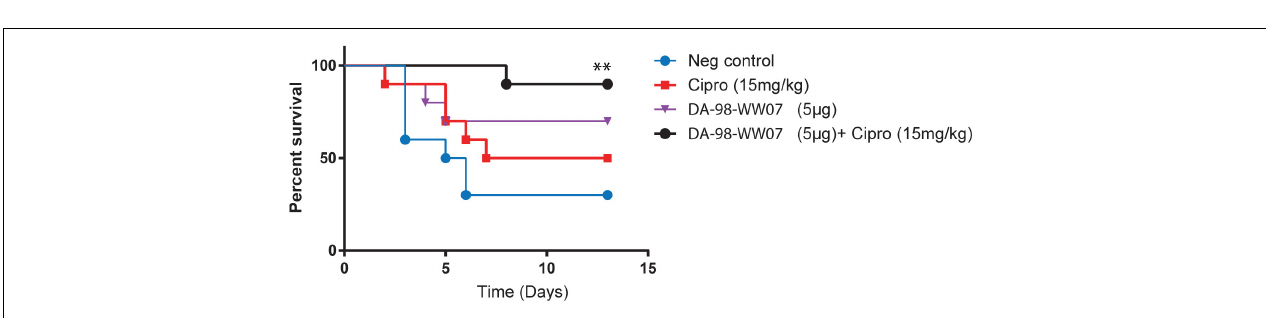
FIGURE 4 | DA-98-WW07 protected mice from B. anthracis infection. Mice survival following infection with B. anthracis . Kaplan-Meier curves of C57BL/6 mice infected with B. anthracis . (A) Mice are treated with indicated TLR agonists 2 h prior to infection and 24 or 48 h post infection. (B) Surviving mice were re-challenged with B. anthracis 20 day post initial infection. The number of mice that were re-challenged in the different groups are DA-98-WW07 –10 µ g (4 mice), DA-98-WW07 –30 µ g (5 mice), DA-98-WW07 –100 µ g (5 mice), Pam 3 CSK 4 - 300 µ g (5 mice), and PBS control (10 mice). Statistically significant differences (Log-rank test) in time to death (days) between treated vs. control groups are indicated. ∗∗∗ indicates p -value < 0.001. ∗∗ indicates p -value < 0.05.